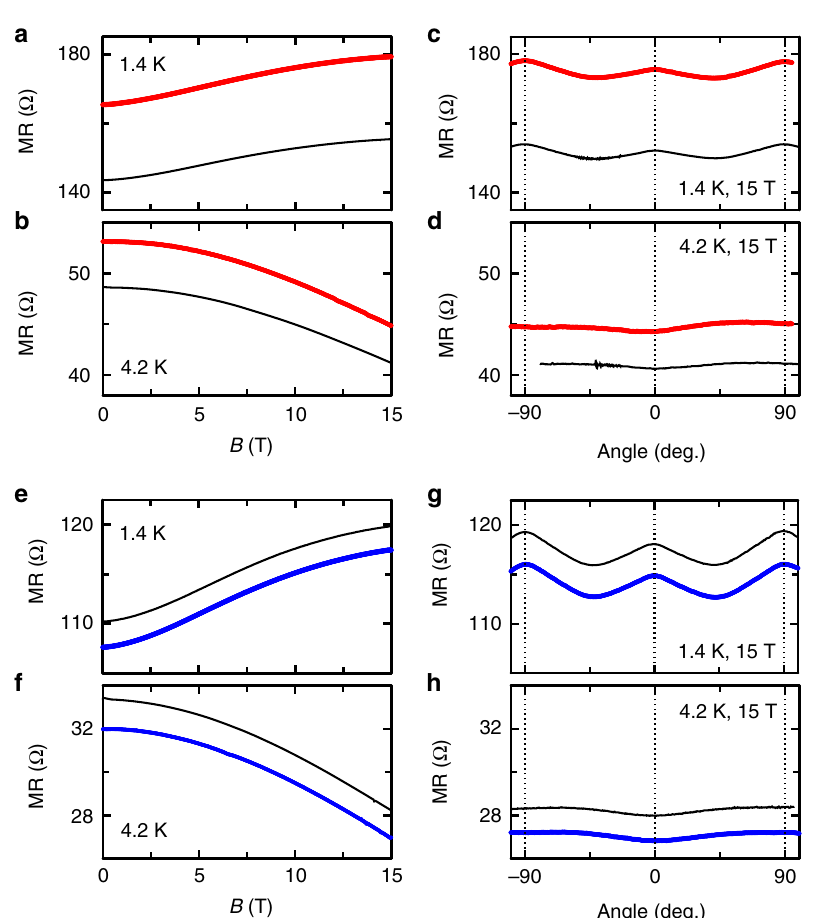
Fig. 5 The change in magnetoresistance under the in fl uence of surface modi fi cation. a – d The change in magnetoresistance induced in sample S1 68 on application of Cr 7 Zn as a function of magnetic fi eld at a 1.4 K and b 4.2 K, and as a function of orientation in high magnetic fi eld at c 1.4 K and d 4.2 K. Black traces represent pristine behaviour; red traces follow the surface modi fi cation. e – h The change in magnetoresistance induced in sample S4 68 on application of Ga 7 Zn as a function of magnetic fi eld at e 1.4 K and f 4.2 K, and as a function of orientation in high magnetic fi eld at g 1.4 K and h 4.2 K. Black traces represent pristine behaviour; blue traces follow the surface modi fi cation. For both surface modi fi cations, the changes in magnetoresistance are small and the form of the magnetoresistance as a function of magnetic fi eld and orientation is preserved, con fi rming that the changes introduced by our surface modi fi cations are perturbative and do not modify the Fermi surface geometry